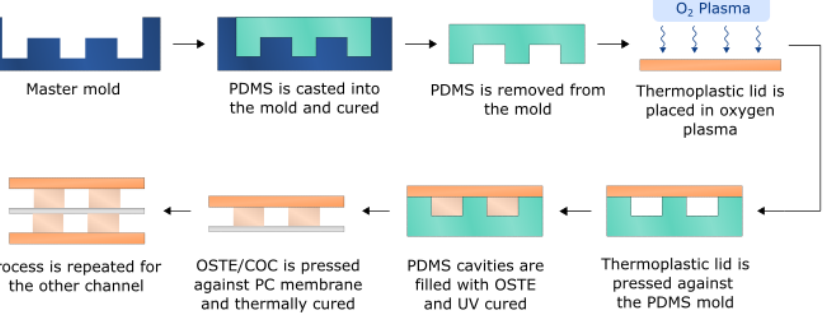
Figure 4. AF4 bifurcation EV separation device fabrication workflow. To retain membrane flatness during the assembly, the top piece was pre-bonded to the membrane before bonding the bottom piece.